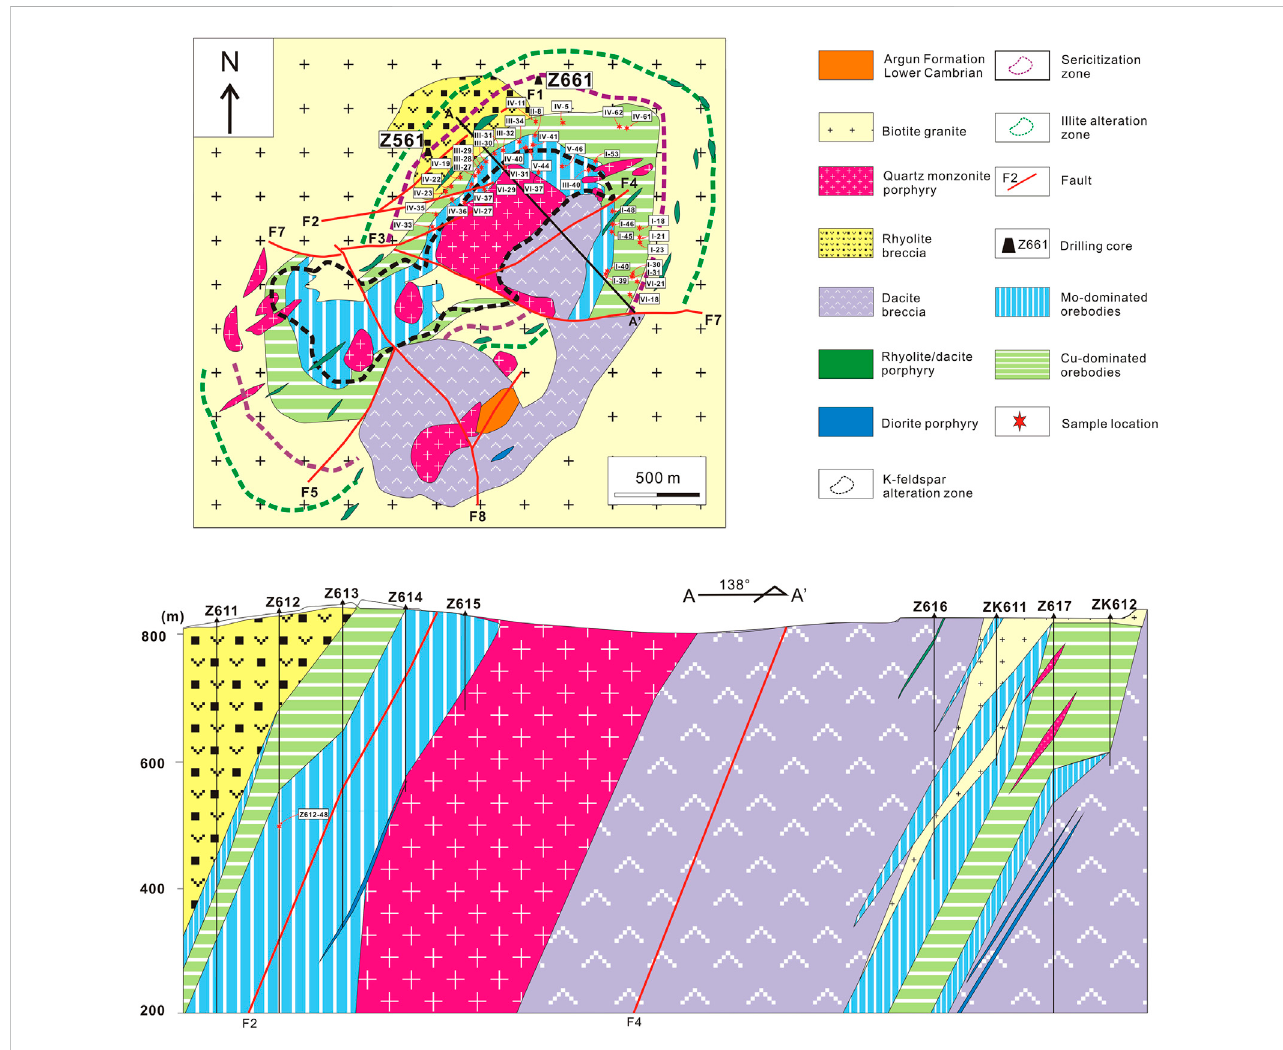
FIGURE 2 Geological map of the Wunugetushan porphyry Cu – Mo deposit geological map (modi fi ed from Wang et al. (2015)) including sample locations.